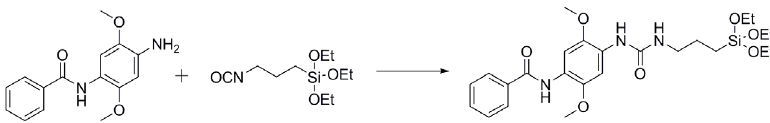
Figure 1. Derivatized Fast Blue RR:Fast blue RR was coupled to 3-(triethoxysilyl)propyl isocyanate. NMR measurements confirm the structure of the stable product.